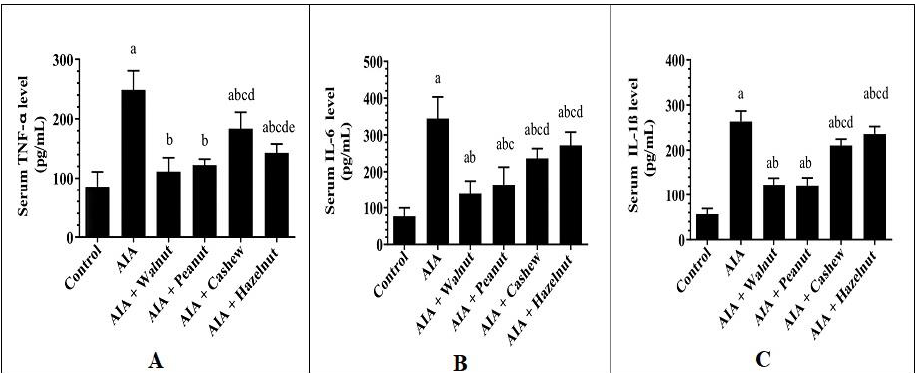
Figure 5. Effect of different nuts ’ oil on serum levels of pro-inflammatory cytokines TNF- α ( A ), IL-6 ( B ), and IL-1 β ( C ) adjuvant-induced arthritis (AIA) rats. Model: One-way analysis of variance (ANOVA) with a statistical significance assumed at p ≤ 0.05 followed by Tukey ’s HSD post hoc test for statistically significant p -value. Data are presented as mean ± SD for n = 5 rats/groups. a: Different from the control rats. b: Significantly different from the adjuvant-induced arthritis (AIA) model rats. c: Significantly different from AIA + walnut oil. d: Significantly different from AIA + peanut oil. e: significantly different from AIA + cashew nut oil.